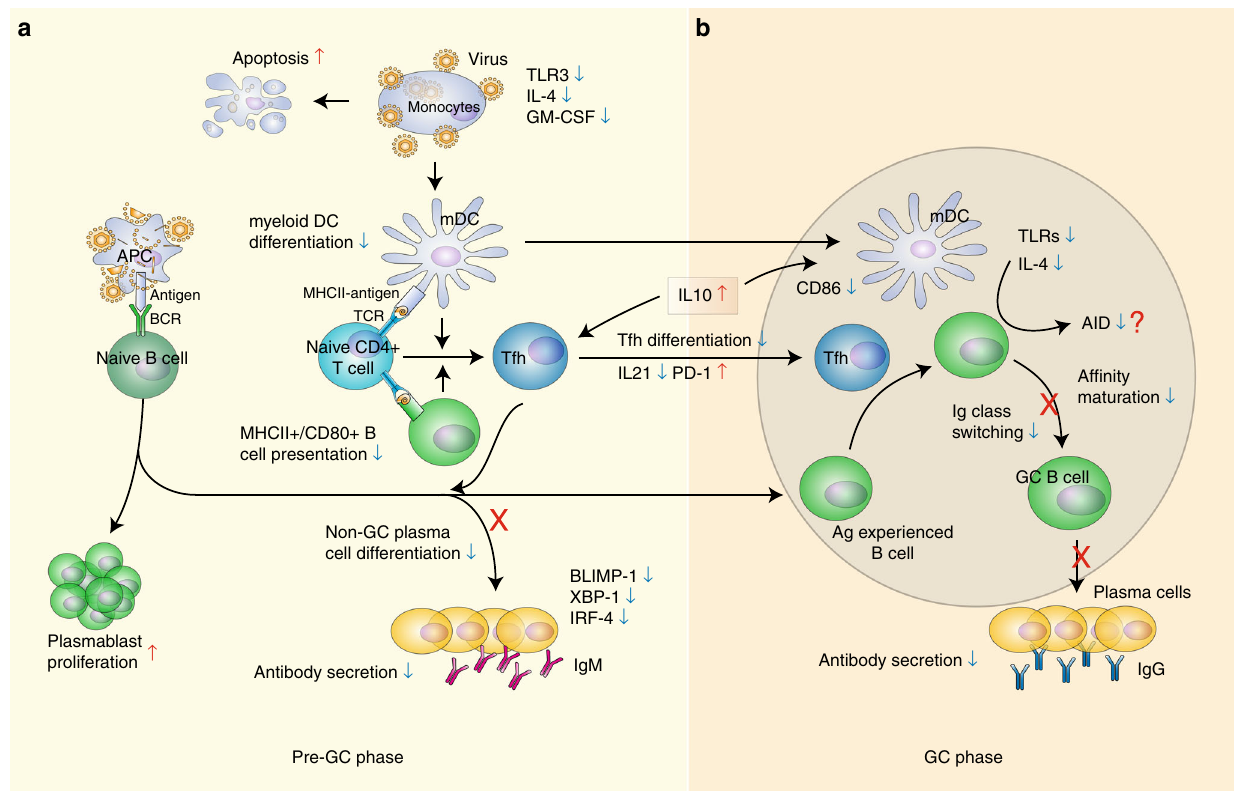
Fig. 9 Schematic presentation of the mechanisms in the defective humoral response to SFTSV infection. a In the pre-germinal center (pre-GC) phase, persistent viremia primes large quantity of naive B cells into PBs and causes massive monocytic apoptosis, resulting in impaired mDC differentiation, accompanied by the downregulation of TLR3, IL-4 and GM-CSF. Due to insuf fi cient MHC-II antigen presentation by mDCs and B cells, the differentiation and function of Tfh are inhibited, characterized by the decreased numbers and downregulation of IL-21 secretion. Additionally, the expression of PD-1 on Tfh, which act as an important inhibitory molecule of T-cell function, was observed to be persistently upregulated in deceased patients. The expression of three key transcriptional factors, BLIMP-1, IRF-4 and XBP-1, was down-modulated due to the lack of Tfh stimulation. PBs failed to differentiate into non-GC plasma cells and were unable to secret IgM antibodies. b In the GC phase, Ag-experienced B cells interact with cognate Tfh and mDC. However, the B-cell maturation is impaired due to the dysfunction of cognate Tfh and mDC, which, together with the downregulation of TLRs and IL-4, inhibited the induction of activation-induced cytidine deaminase (AID), resulting in the complete inhibition of immunoglobulin class-switch in the deceased patients. Red upward arrow and blue downward arrow denote up and downregulation,